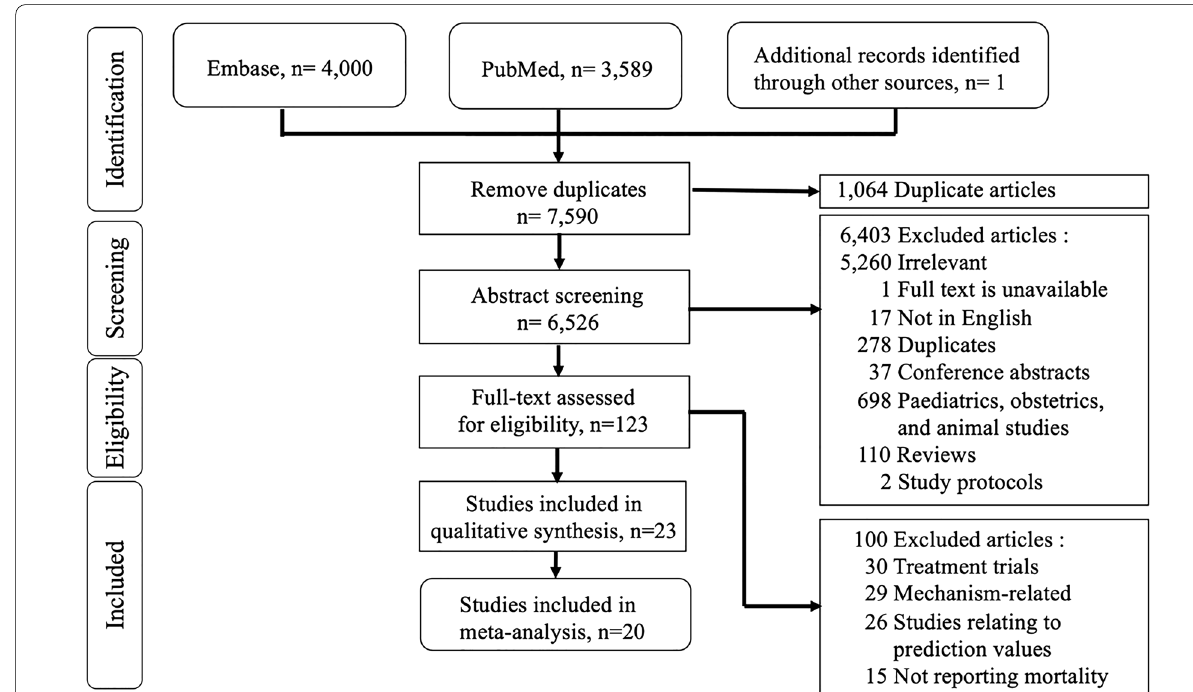
Fig. 1 Literature search flow diagram according to the Preferred Reporting Items for Systemic Reviews and Meta‑Analyses (PRISMA)